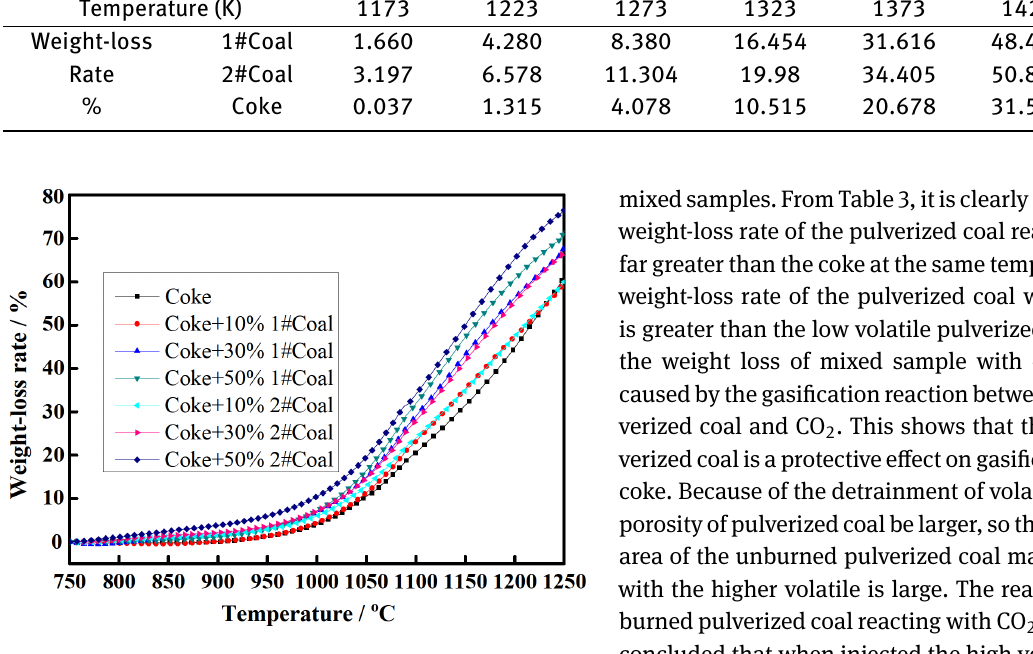
Figure 2: Weight-loss rate curves of gasification reaction on char- CO